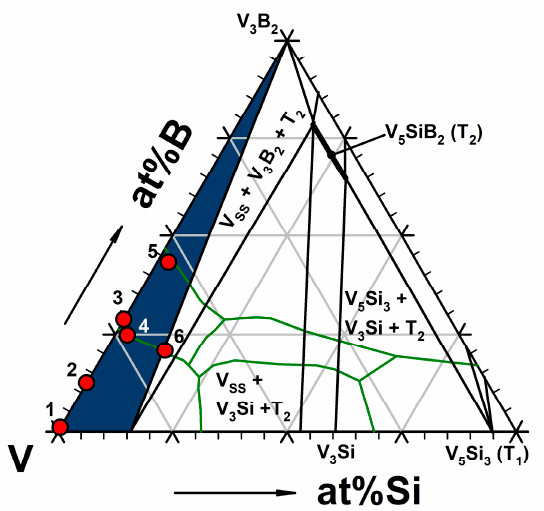
Figure 1. Isothermal section at 1600 °C of the V ‐ Si ‐ B system after Nunes [17] including investigated alloys (red spots, compositions are given in Table 1) in the V SS ‐ V 3 B 2 phase region (blue area) and the liquidus projection [19] of the V ‐ rich corner (green line).